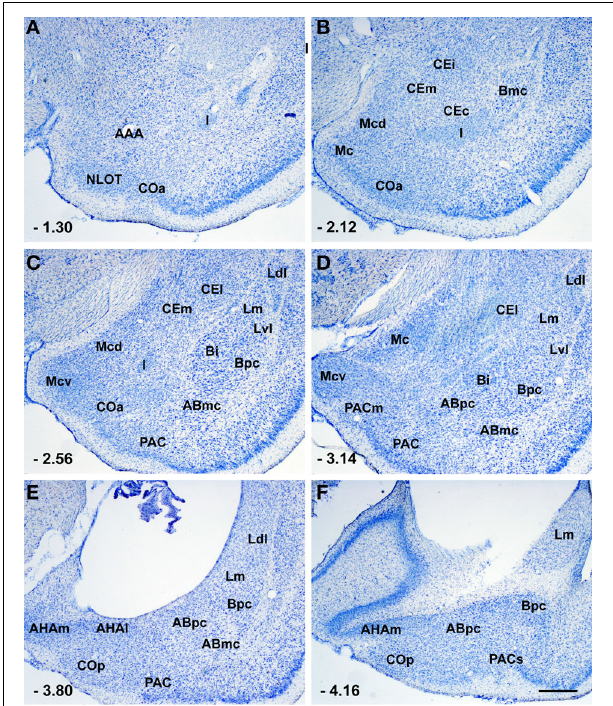
FIGURE 1 | Photomicrographs from thionin-stained coronal sections of the rat amygdala showing the various nuclei and nuclear subdivision. Scale bar = 500 μ m in (F) ( applied to A–F) . For abbreviations see Table 1 . The numbers in the lower left corner correspond to the distance from bregma according to rat brain atlas of Paxinos and Watson